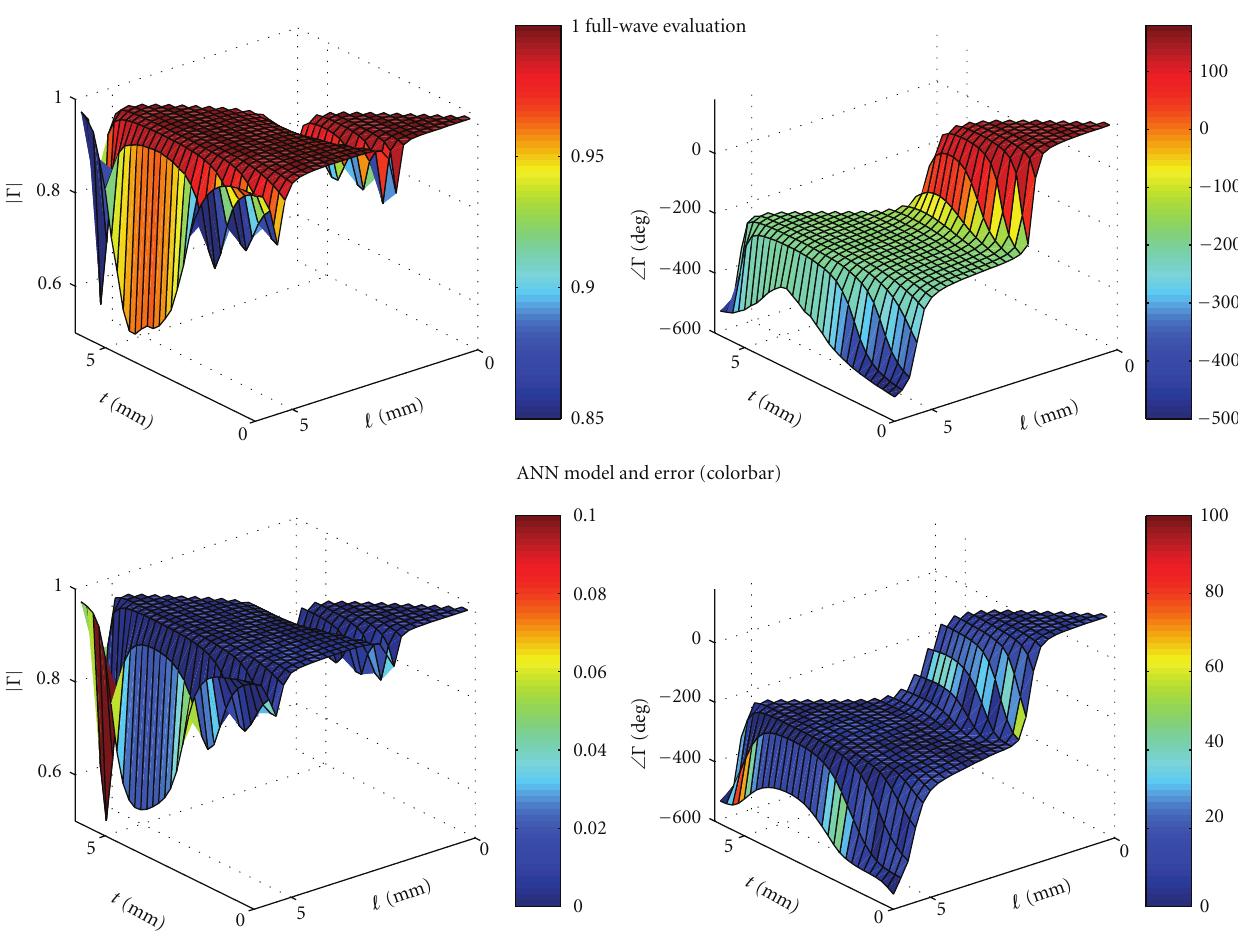
Figure 8: Reflection coe ffi cient amplitude (left) and phase (bottom) versus the two RA geometrical parameters (cid:2) and t of the modified Malta Cross, computed with direct full-wave (top) and reconstructed with the ANN (bottom). f = 11 . 7 GHz, θ inc = 65 ◦